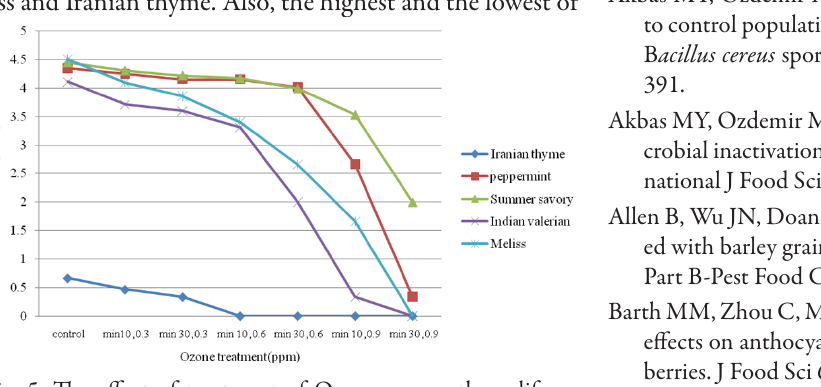
Fig. 5. The effect of treatment of Ozone gas on the coliform count in medicinal